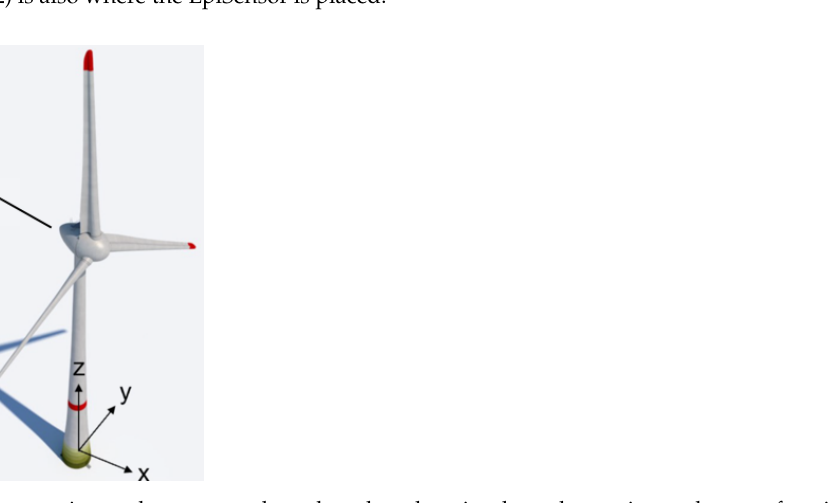
Figure 1. The experiment set-up showing (1) the KR AGILUS-2, KR 6 R900 sixx robot arm, (2) KVH 1750 IMU, and (3) Javad GrAnt G3T Global Navigation Satellite System (GNSS) Antenna. The location of (2) is also where the EpiSensor is placed.